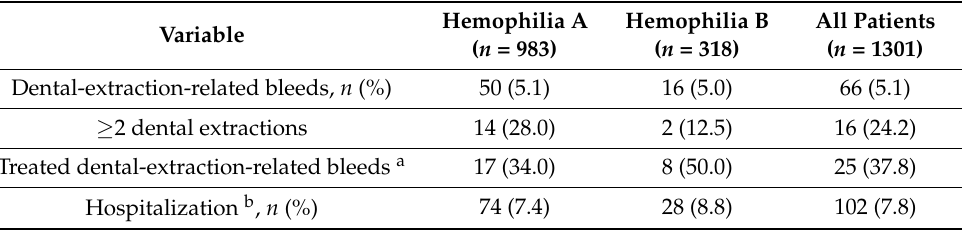
Figure 2. Number of dental extractions by hemophilia type, 2013–2019. Table 2. Clinical outcomes and treatments related to dental extraction episodes among hemophilia patients, 2013–2019 ( n = 1301 dental extraction